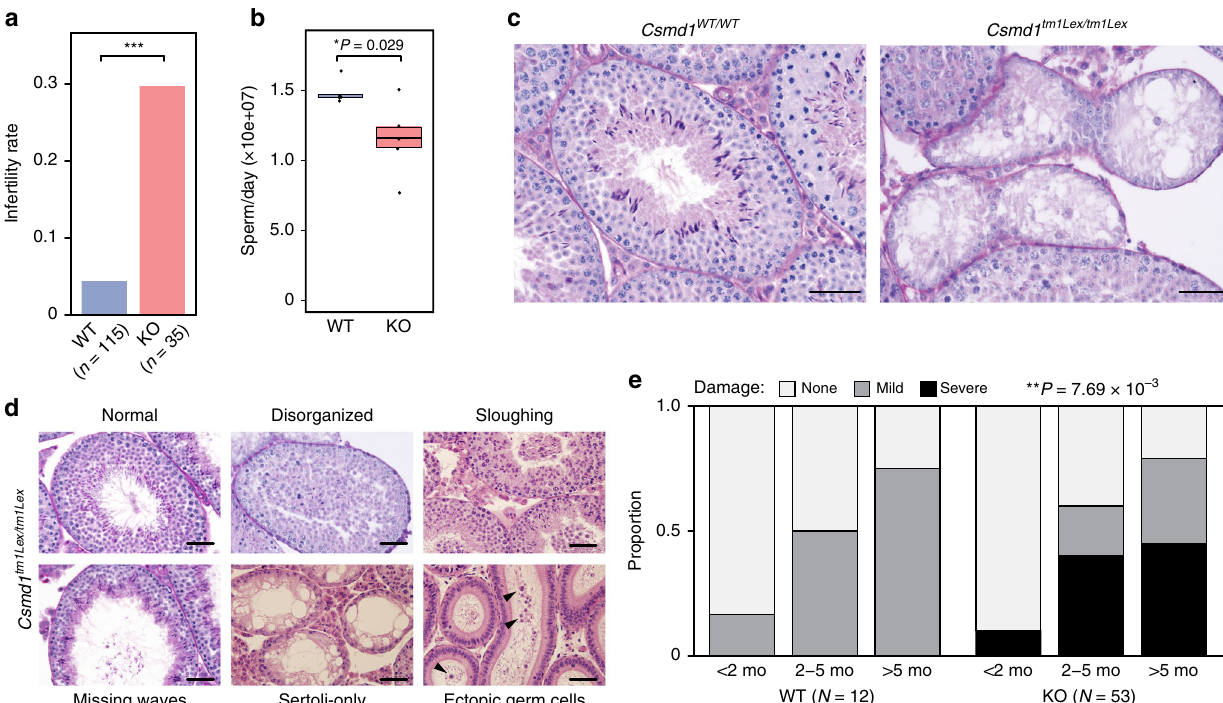
Fig. 3 Variable reproductive defects in Csmd1 KO males. a Barplot depicting proportions of infertile Csmd1 wildtype (WT) vs. knockout (KO) males. KO males showed signi fi cantly higher rate of infertility (relative risk = 6.8, linear regression p -value = 4 × 10 − 4 ). b Daily sperm production is 25% lower in knockout testes after controlling for age (Wald test p -value = 0.029). Center line = median; hinges = upper and lower quartiles. c Seminiferous